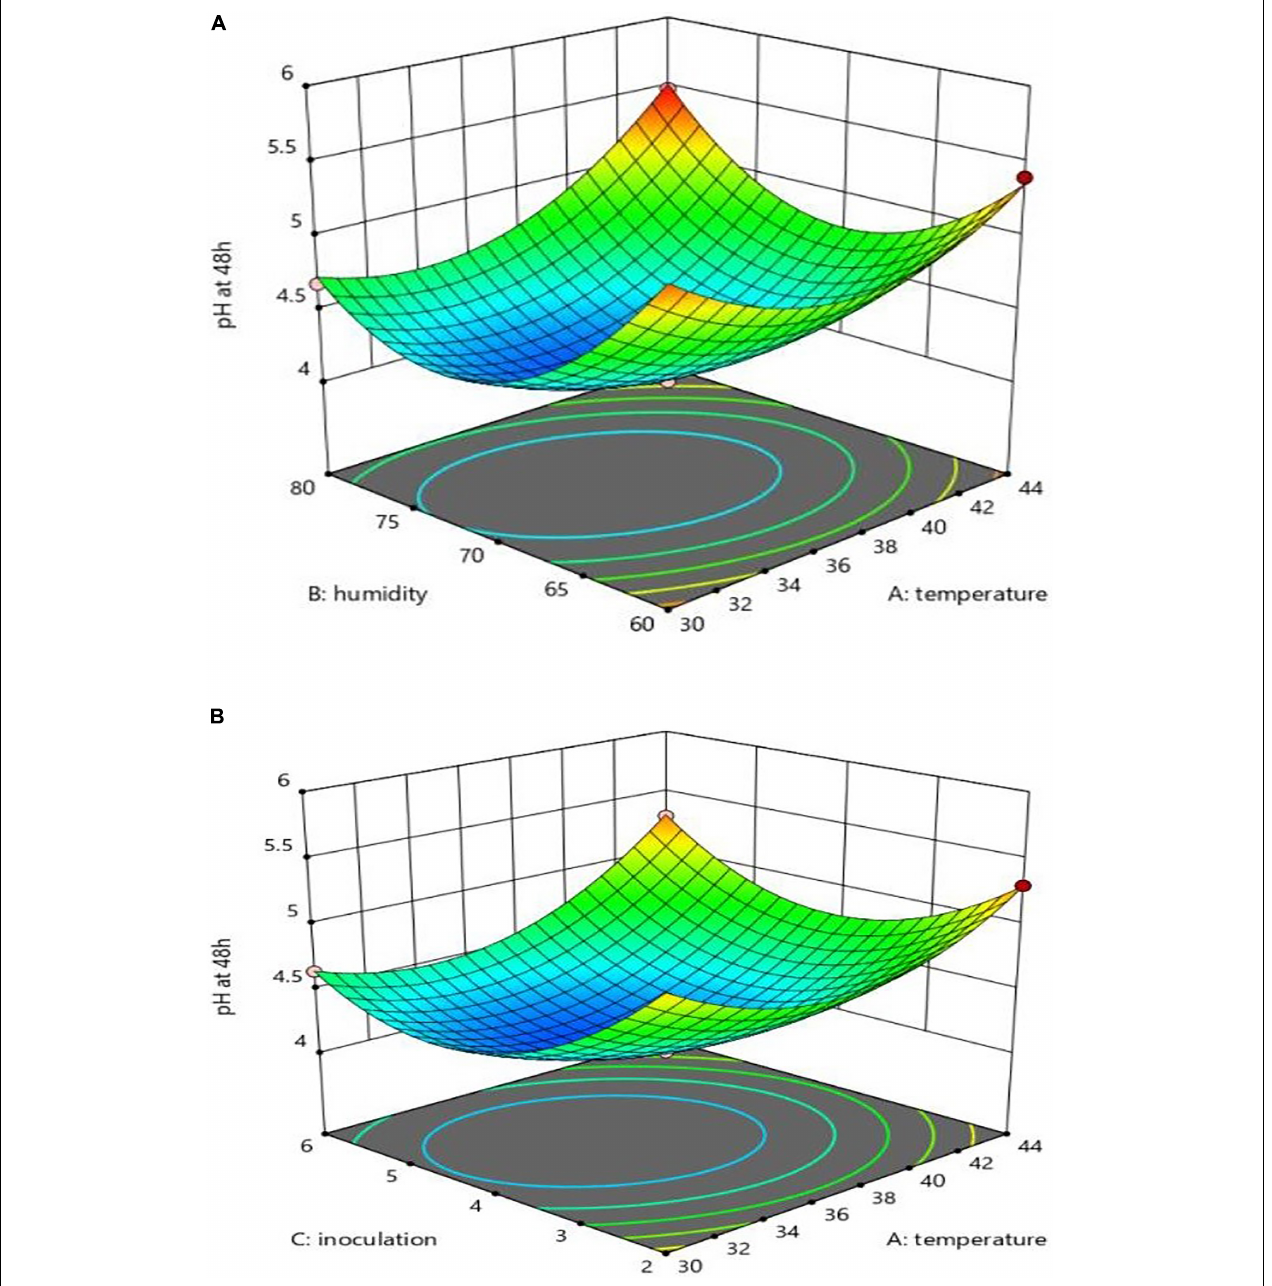
FIGURE 2 | Interaction effect of temperature and humidity (A) , and temperature and inoculation (B) on